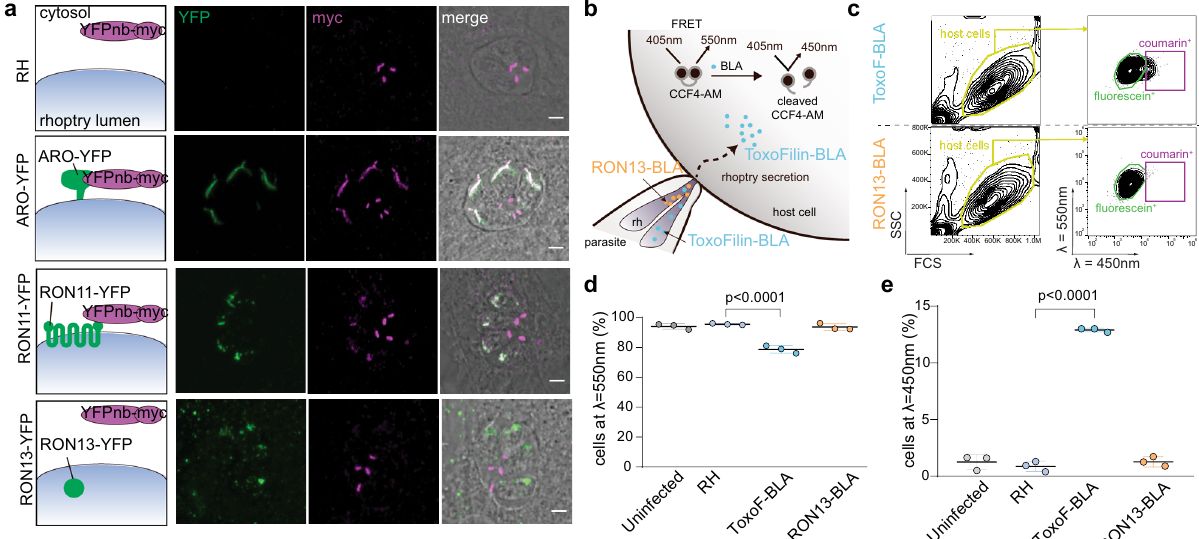
Fig. 2 RON13 is a luminal rhoptry protein that is not secreted during invasion. a IFAs of RH-, ARO-YFP- (green), RON11-YFP- (green), or RON13-YFP- (green) expressing parasites transiently transfected with cytosolic nanobodies targeting YFP fused to a myc-tag (YFPnb-myc). ARO is a protein associated with the cytosolic face of the rhoptry membrane and RON11 is a type III transmembrane protein with its C-terminal domain exposed in the parasite cytoplasm. The myc signal (magenta) observed at the basal part of the parasite is unspeci fi c. Left panels show the schematic topology of the proteins and their ability to bind the cytosolic YFPnb-myc. Scale bar = 2 μ m. Image representative of three biologically independent experiments. b Principle of the experimental design for the FRET-based rhoptry secretion assay used to determine if RON13 (orange) is secreted into the host cell during the invasion. Toxo fi lin (blue) is a soluble rhoptry protein secreted into the host cell. c Gating strategy for quanti fi cation of fl uorescein + cell (green gate; λ = 550 nm) and coumarin + cell (violet gate; λ = 450 nm) frequency for RON13-BLA- and Toxo fi lin-BLA-infected cell monolayer (yellow gate) analyzed by fl ow cytometry. d , e Frequency of fl uorescein + cells ( λ = 550 nm, d ) or coumarin + cells ( λ = 450 nm, e ) in each condition (mean ± SD; n = 3 biologically independent experiments). Statistical signi fi cance was assessed by a one-way ANOVA signi fi cance with Tukey ’ s multiple comparison. Source data are provided as a Source data fi le.